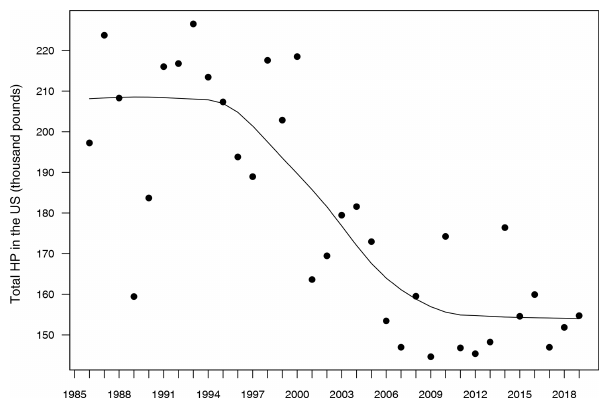
Figure 1. Evolution of total honey production in the USA from 1985 to 2019. Units in the y axis are shown as thousand pounds. The solid line represents a temporal trend fitted by a lo- cally weighted polynomial regression.